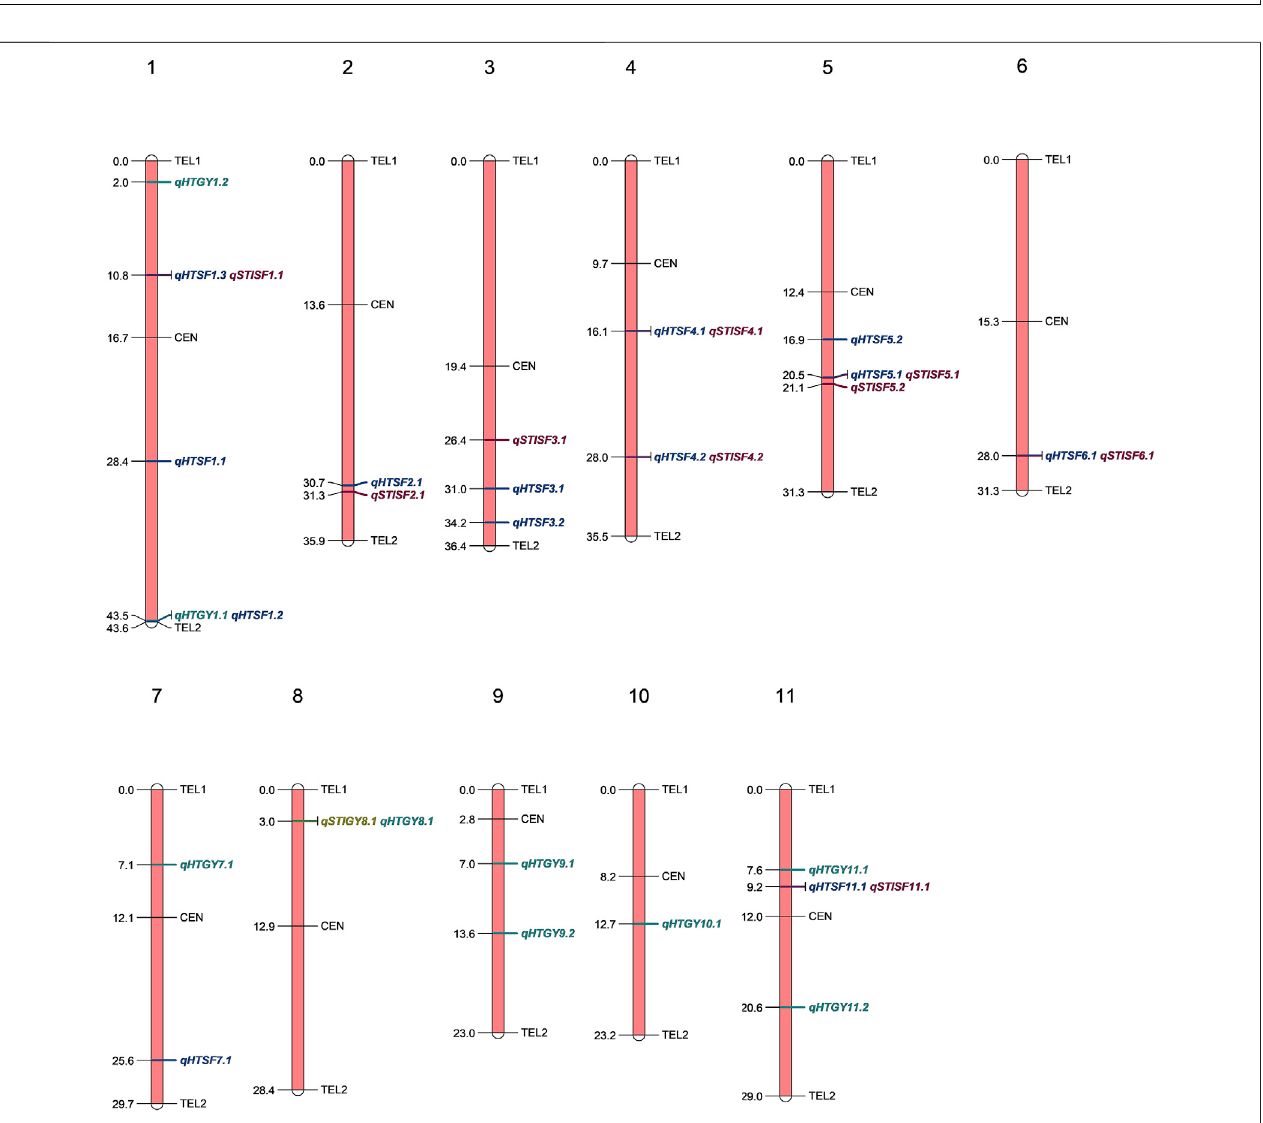
FIGURE 5 | Physical positions (Mb) of various MTAs identi fi ed across the rice genome through various models employed in GAPIT.